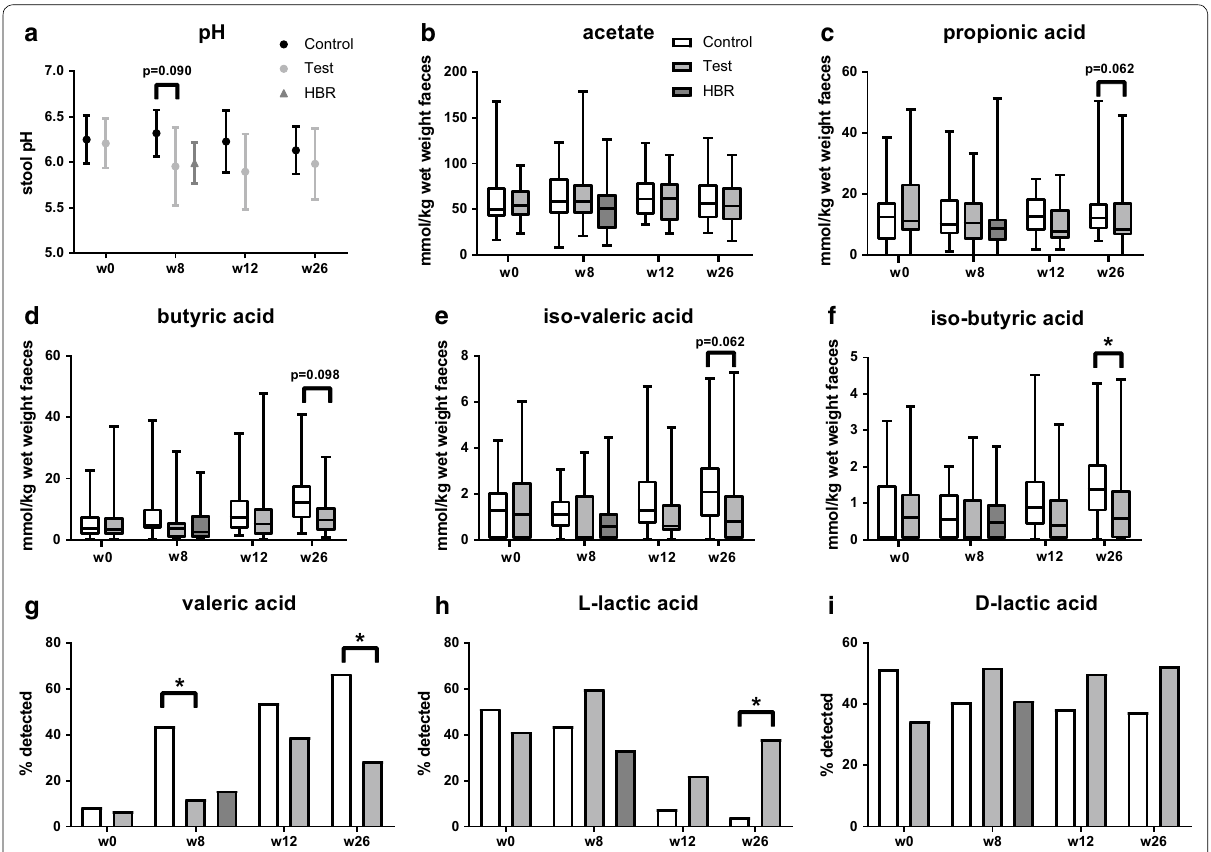
Fig. 5 Mean with 95% CI of stool pH ( a ) for treatment by time. The box‑plots summarize the amounts (in mmol/kg) of acetate ( b ), propionate ( c ), butyrate ( d ), iso‑valerate ( e ), iso‑butyrate ( f ) for treatment by time, respectively. Percentage of faecal samples (plotted as bars) with detectable levels of valerate ( g ), l ‑lactate ( h ), and d ‑lactate ( i ) for treatment by time, respectively. The HBR reference values (age‑matched to week 8) are plotted as well. P‑values for stool pH and acetate are based on ANCOVA comparing Test versus Control with week 8/12/26 values as outcome, stratification factor and baseline values as covariate and treatment as fixed effect. P‑values for the variables summarized in c – e are based on Van Elteren test comparing test versus control with respect to change from baseline at week 8/12/26, taken the stratification factor into account. P‑values for the variables summarized in g – i are obtained from a logistic regression model comparing test versus control at week 8/12/26 with adjustment for baseline values. *P ≤